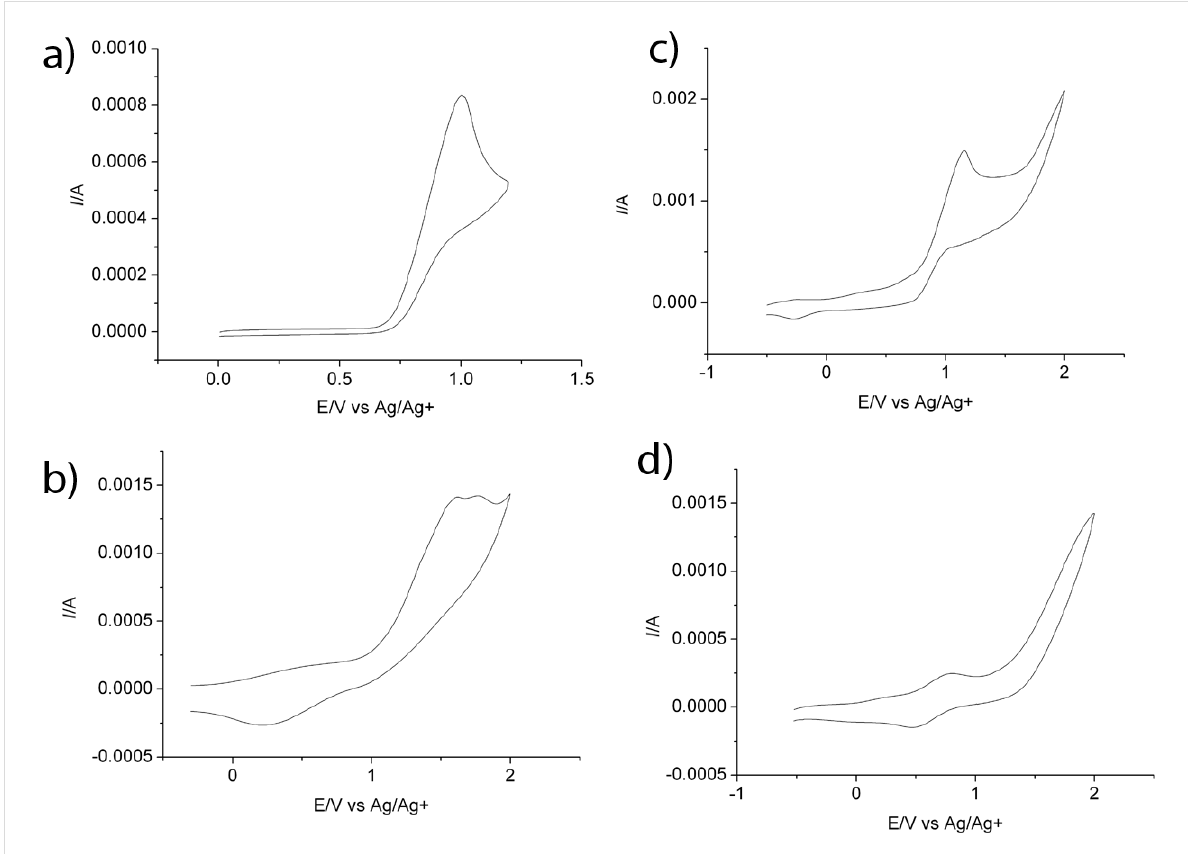
Figure 10: Cyclic voltammograms in DMF of (a) SG1 (10 − 2 M)/ NaClO 4 (10 − 1 M) and (b) LiCl (10 − 2 M)/TBAPF 6 (10 − 1 M). Cyclic voltammograms in MeOH of (c) SG1 (10 − 2 M)/TBAPF 6 (10 − 1 M) and (d) LiCl (10 − 2 M)/TBAPF 6 (10 − 1 M). Glassy carbon electrode, Ag/AgCl, Pt, sweep rate 50 mV·s − 1 .